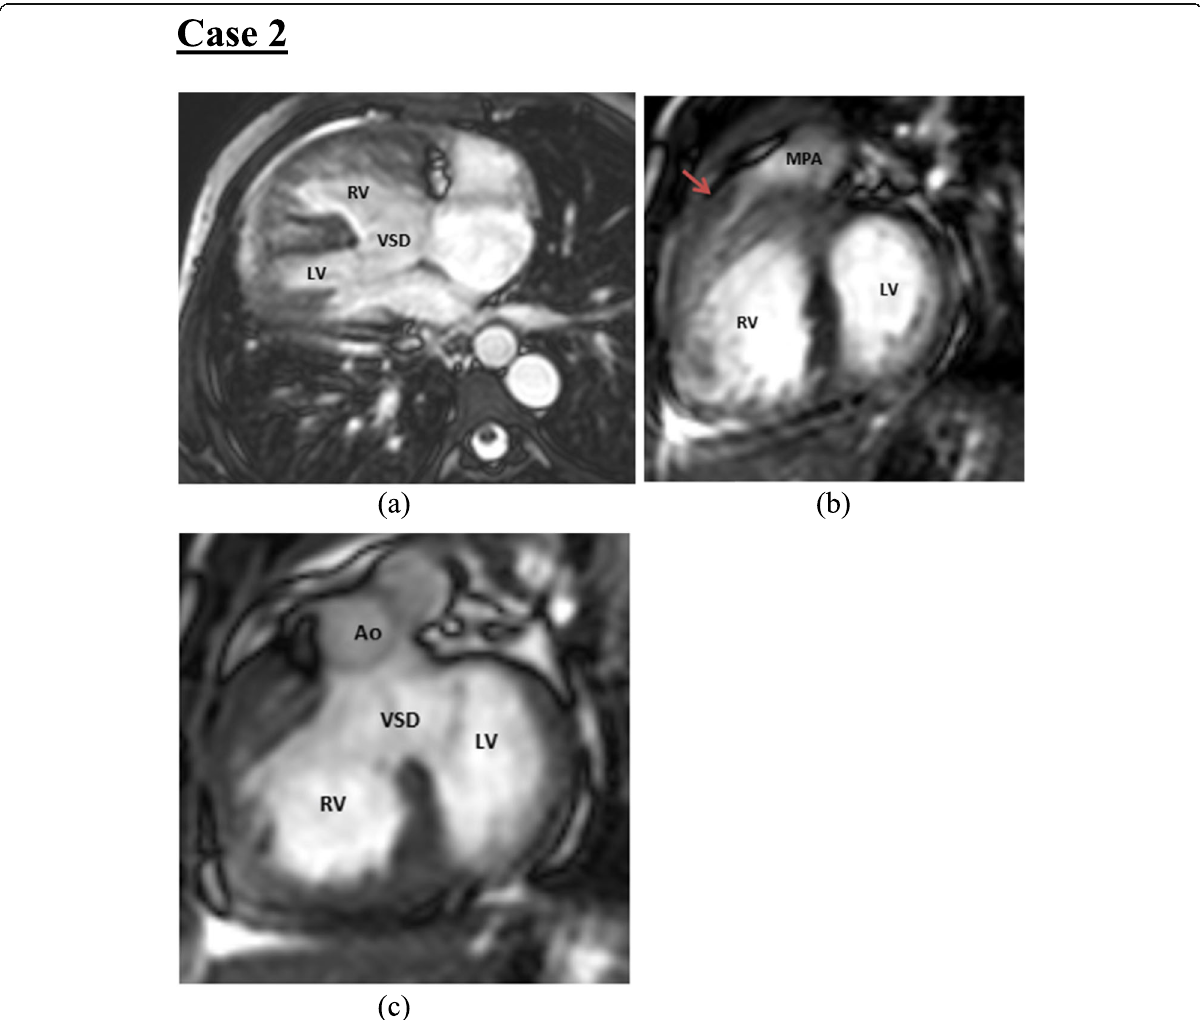
Fig. 2 A case of pre-operative TOF. cine MRI images showing a axial view showing Dextrocardia with right ventricular hypertrophy. b SA view showing infundibular pulmonary stenosis “ red arrow ” . c SA view showing subaortic